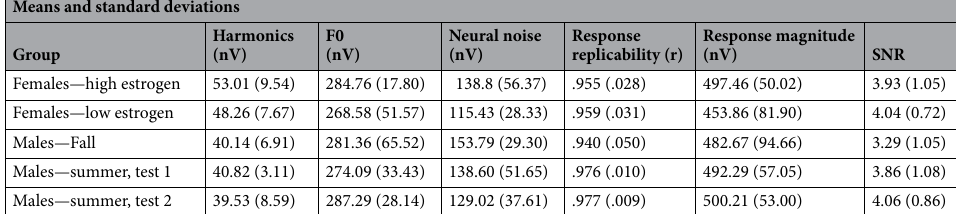
Table 1. Means and standard deviations for each group on the 6 FFR